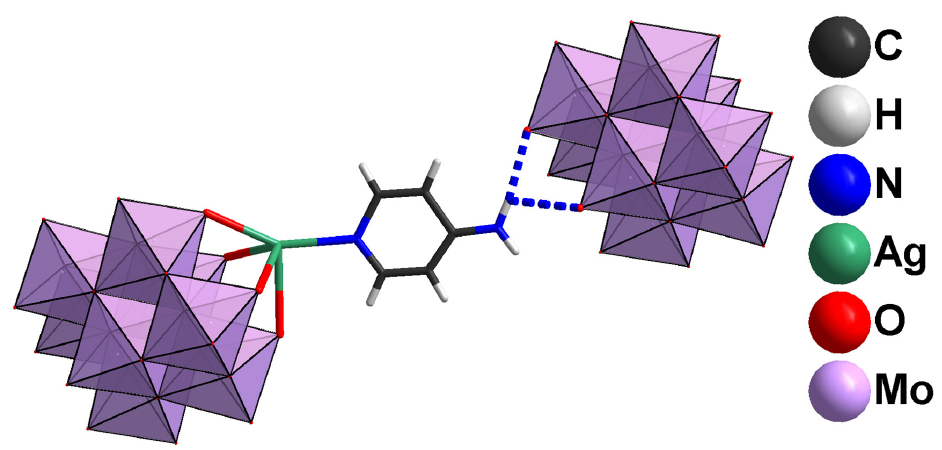
Figure 1. py ‐ NH 2 …O=Mo interactions in the crystal structure of 1 . Three typical bonding distances surround Ag + : d(Ag1 ‐ N1) = 2.27(3)Å, d(Ag1 ‐ O6) = 2.372(7) Å, d(Ag1 ‐ O2) = 2.544(6) Å and two longer contacts d(Ag1 ‐ O9) = 2.639(7) and d(Ag1 ‐ O13) = 2.689(7) Å indicate CN = 3+2 for Ag + . These distances are in agreement with the previously published pyridinium complexes of this type [50]. The distances for py ‐ NH 2 …O=Mo interactions fill the interval between 2.974 and 3.285 Å. The shortest N…O contacts 2.974 and 3.021 Å are depicted in blue in Figure 1.